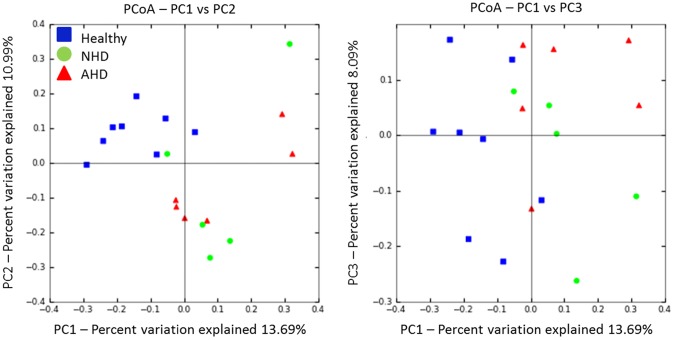
Principal Coordinate Analysis (PCoA) of unweighted UniFrac distances of 16S rRNA genes.Blue squares = healthy dogs, green circles = acute non-hemorrhagic diarrhea (NHD), and red triangles = acute hemorrhagic diarrhea (AHD); ANOSIM for healthy dogs vs. dogs with AD (NHD and AHD combined), p = 0.0040; and ANOSIM for NHD or AHD vs. healthy dogs, p = 0.0020 for both.